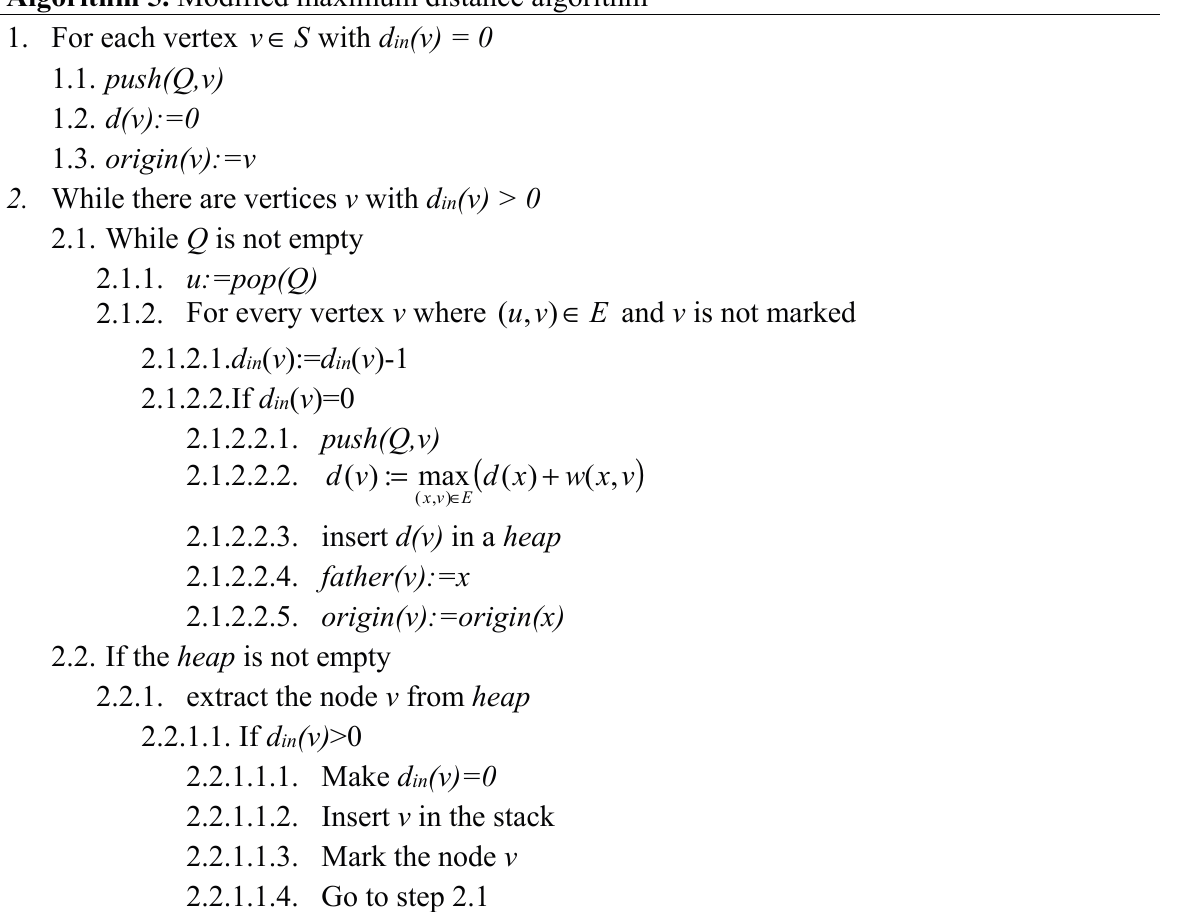
Algorithm 5. Modified maximum distance